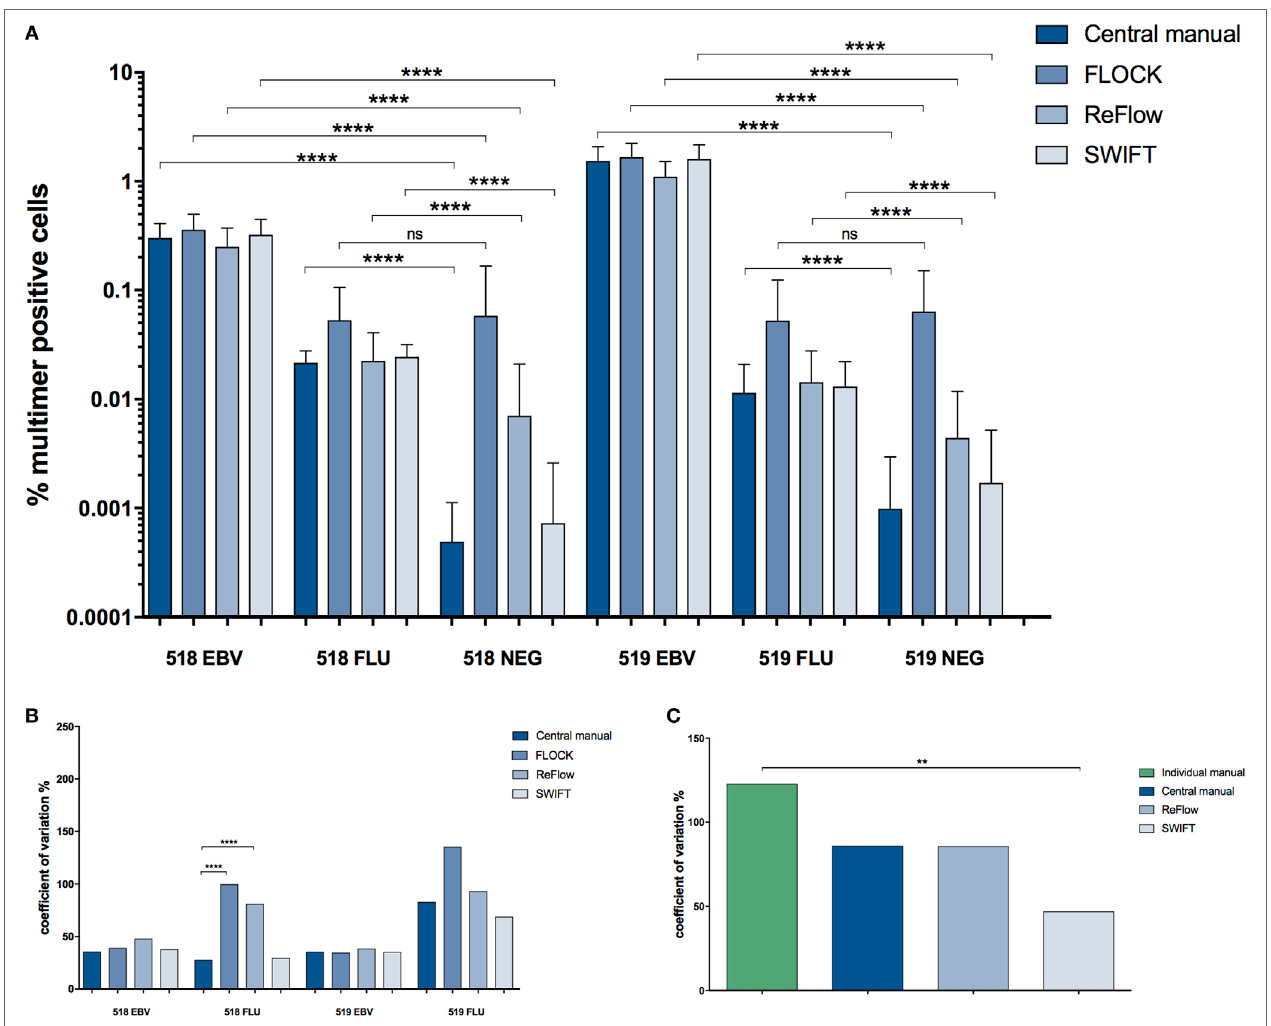
FigUre 4 | Comparison of the different analysis methods. (a) Percentage of MHC multimer + T cells out of single, live lymphocytes found using the different analysis approaches for identification of T cells recognizing two different virus-derived epitopes (EBV, FLU) in two different donors (518, 519). Error bars indicate SD. ****: p < 0.0001; ns: not significant (paired t -test). Central manual: n = 28, FLOCK: n = 28, ReFlow: n = 23, SWIFT: n = 27. (B) The coefficient of variation (CV) (SD/ mean*100) for the different analysis approaches in determining the frequency of MHC multimer + T cells. ****: p < 0.0001; no line: no significant difference (asymptotic CV equality test). (c) The CV (SD/mean*100) specifically related to the FLU-specific response in donor 519. **: p < 0.01; no line: no significant difference (asymptotic CV equality test). For (c) , the CV is calculated based on percentage of MHC multimer + T cells out of total CD8 T cells in order to compare with individual manual gating. 518: healthy donor 518; 519: healthy donor 519; EBV: Epstein–Barr virus; FLU: influenza